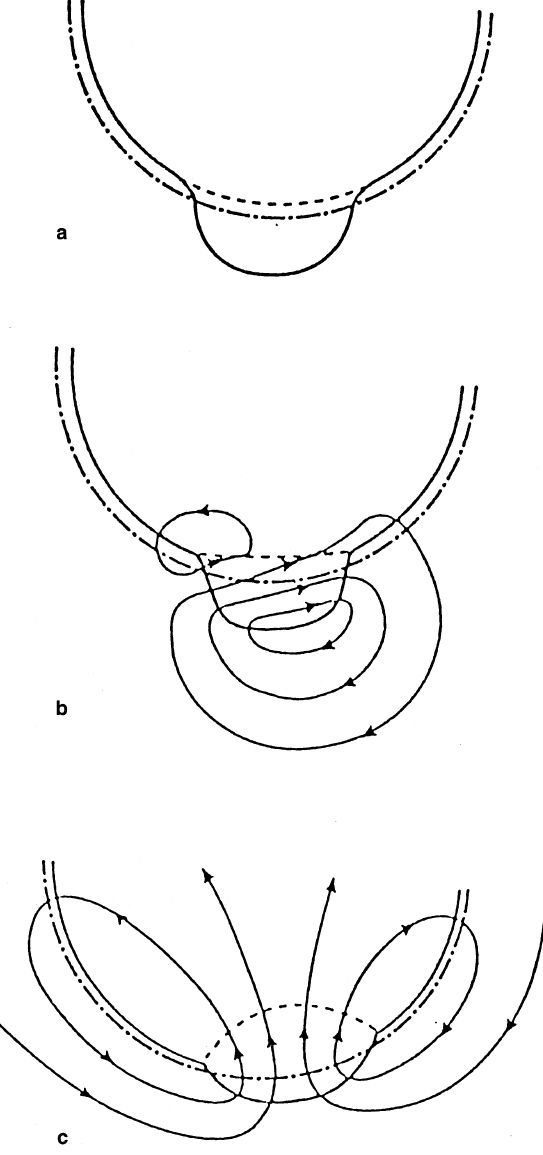
Fig. 8a–c. Three phase model of the ionospheric response to a single pulse of magnetopause reconnection (from